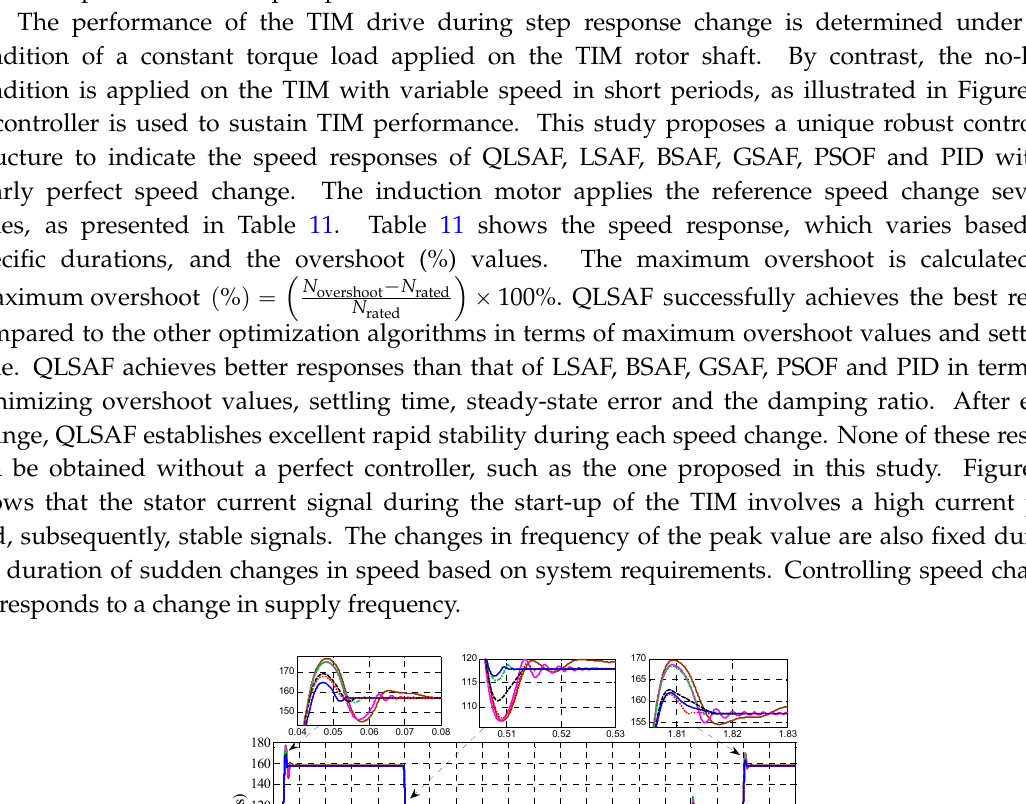
Figure 17. Slip speed output surface.